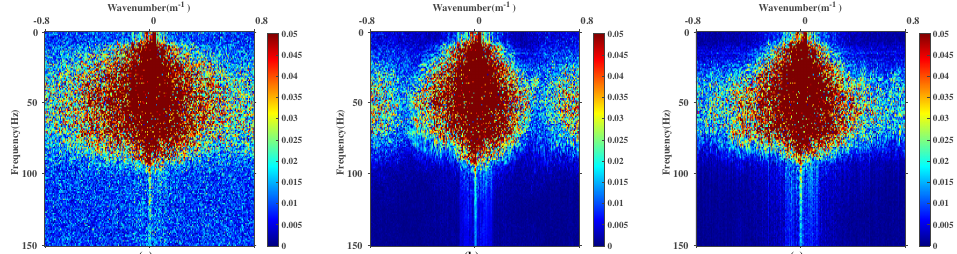
Figure 11. The comparison of the FK spectrum in real seismic data. ( a ) The FK spectrum of contami- nated real seismic data. ( b ) The FK spectrum of the denoised result using U-Net without the noise level map. ( c ) The FK spectrum of the denoised result using attention-CNN with the noise level